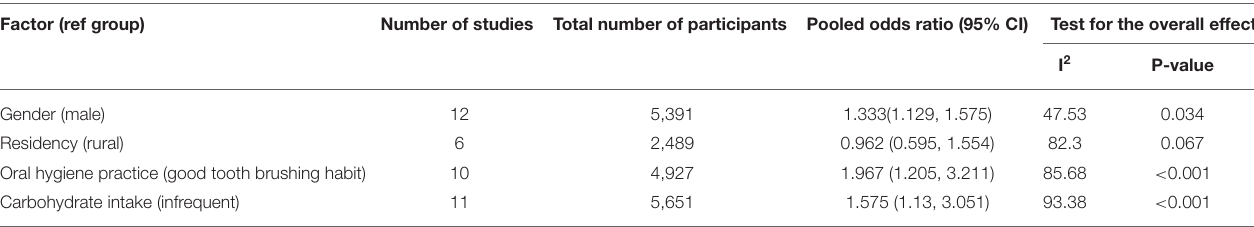
TABLE 2 | Risk factors of dental caries in East